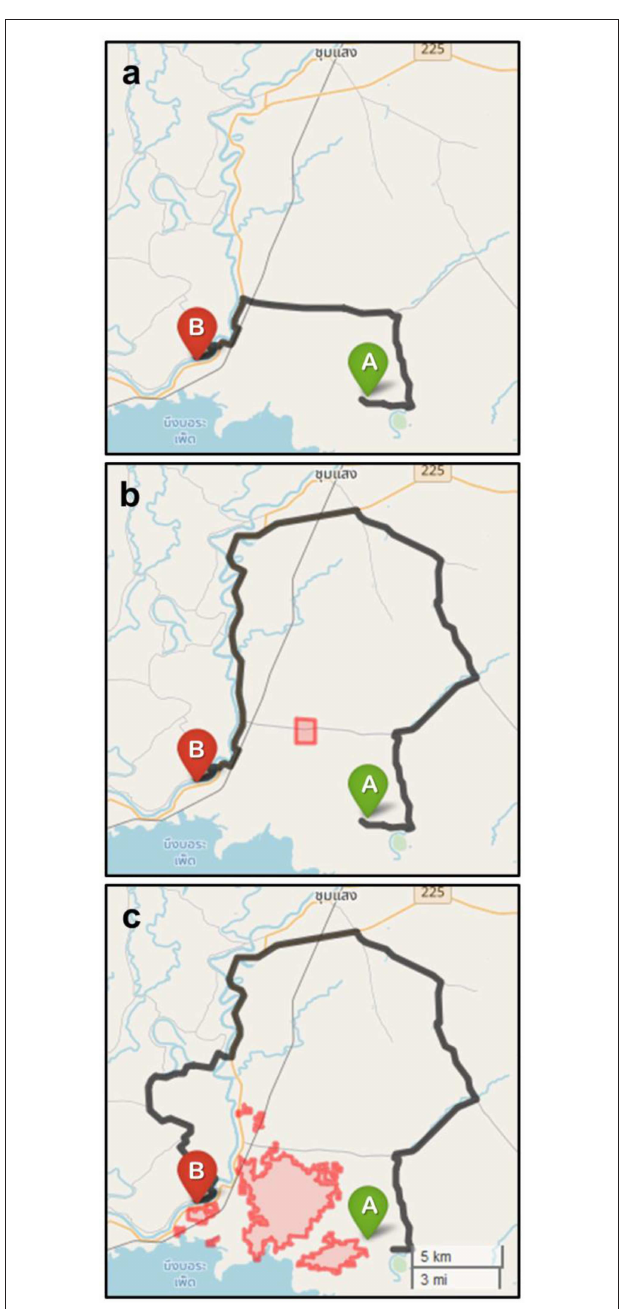
FIGURE 5 | (a) Demonstration of OpenRouteService routing API from origin point A to destination point B. (b) Example of “avoid_polygon” parameter in which the system will route around a user-specified roadblock. (c) Coordinates of the flood vertices used as “avoid_polygon” feature to simulate Highly Flooded